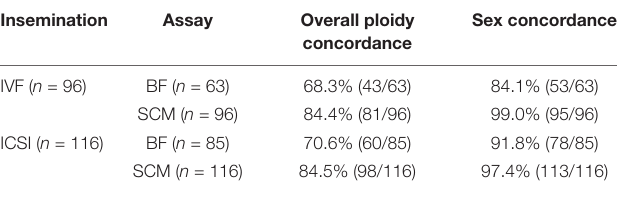
TABLE 2 | Chromosome ploidy and sex consistency in different fertilized